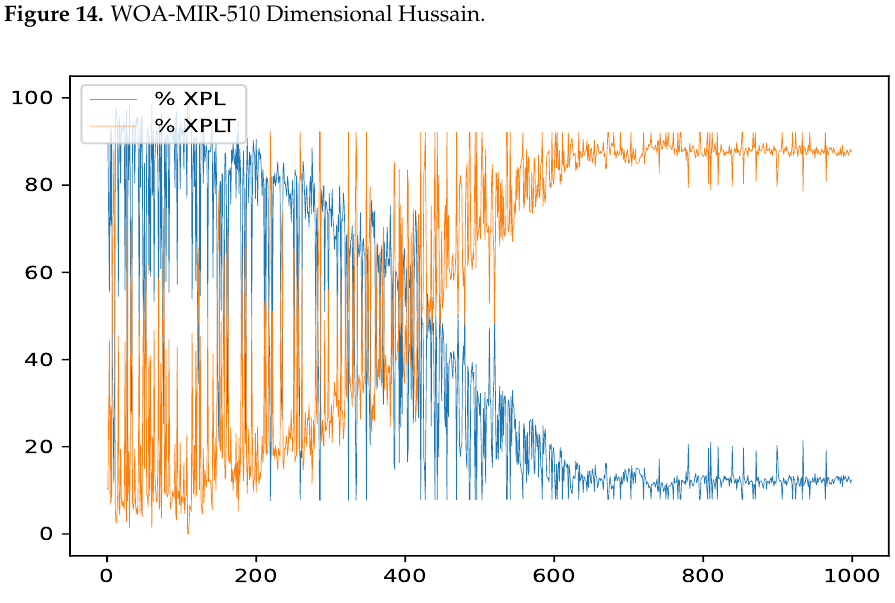
Figure 15. WOA-SA1-510 Dimensional